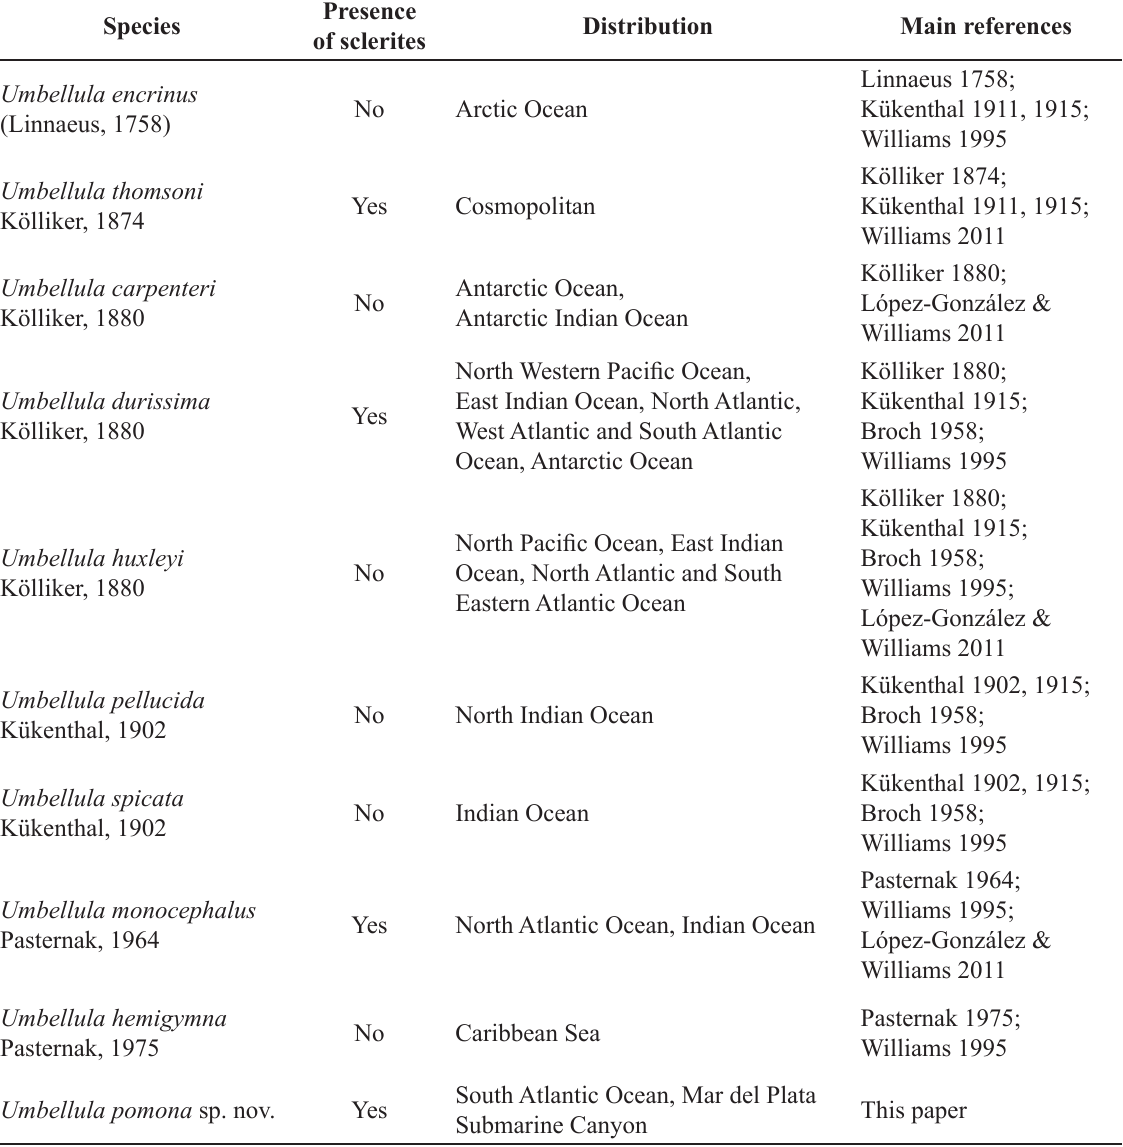
Table 3. Distribution of the currently considered valid species of the genus Umbellula Cuvier,